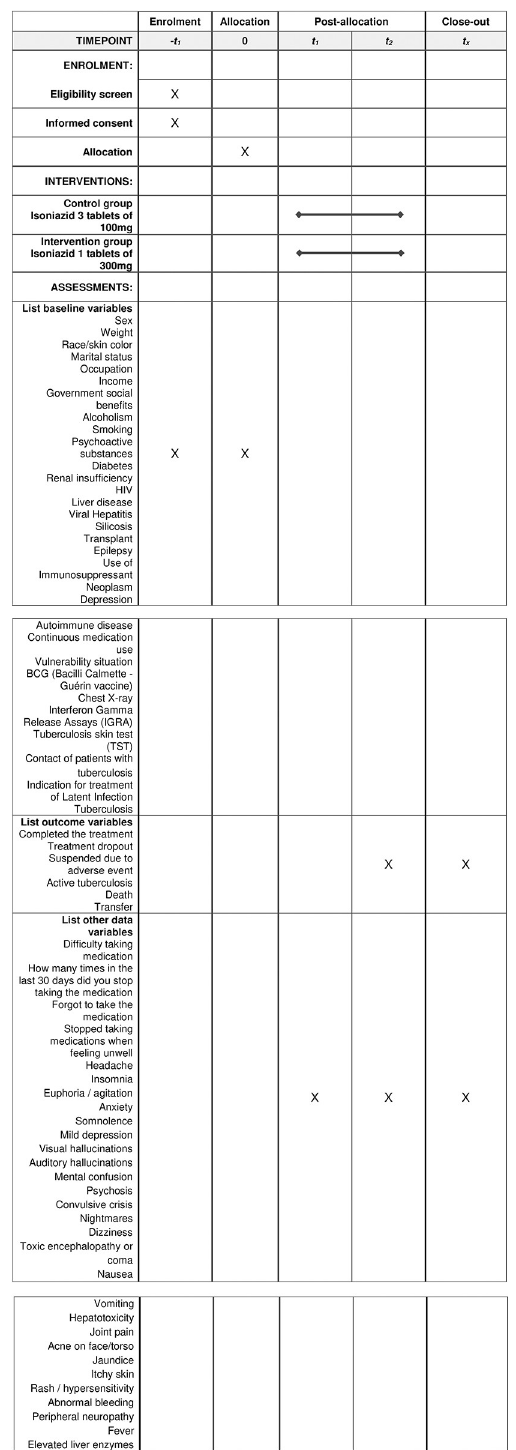
Fig 1. Schedule of enrolment, interventions, and assessments for the protocol for pragmatic randomized clinical trial to evaluate the completion of treatment of latent Mycobacterium tuberculosis infection with Isoniazid in the 300 mg formulation, Brazil, from 2019 to